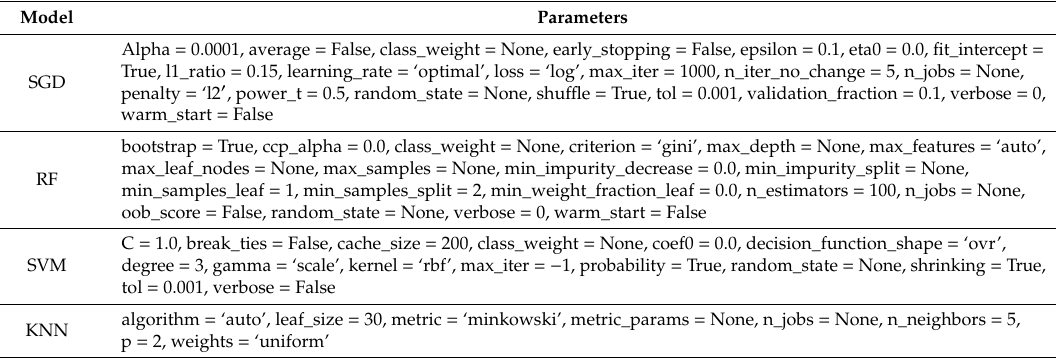
Table 1. Classification parameters for the optimized models. SGD: Stochastic Gradient Descent, RF: Random Forest, SVM: Support Vector Machine, KNN: K-Nearest Neighbor, AB: Adaptive Boosting, DT: Decision Tree, LR: Logistic Regression, GNB: Gaussian Naïve